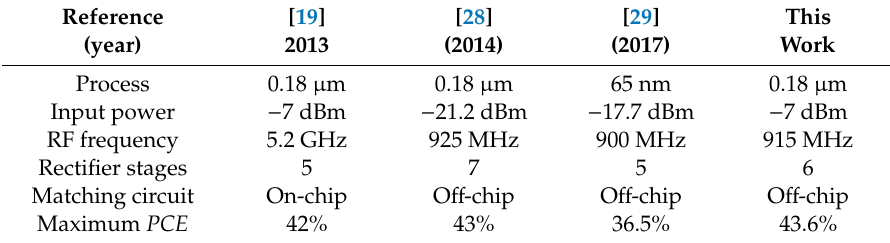
Figure 16. Simulated total PCE of the proposed RF-energy-harvesting IC. Table 1. Summary of performance and its comparison with those of previous RF-DC rectifiers.